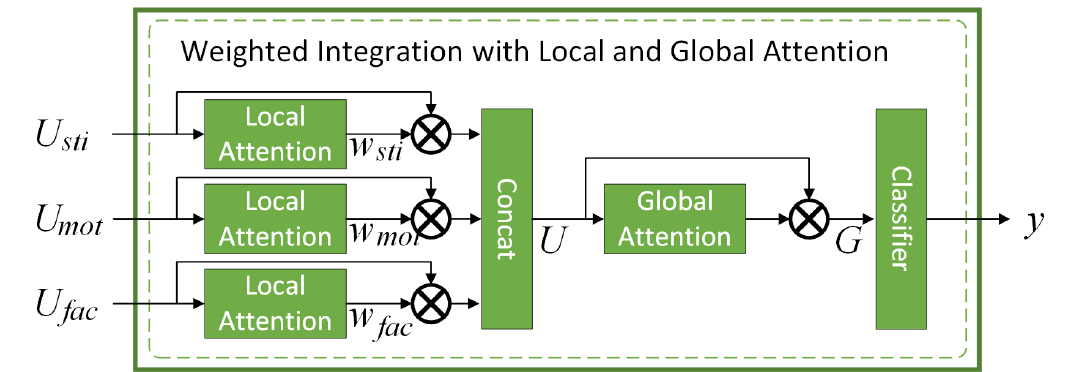
Figure 4. Integrating face- and action-level representations for stress